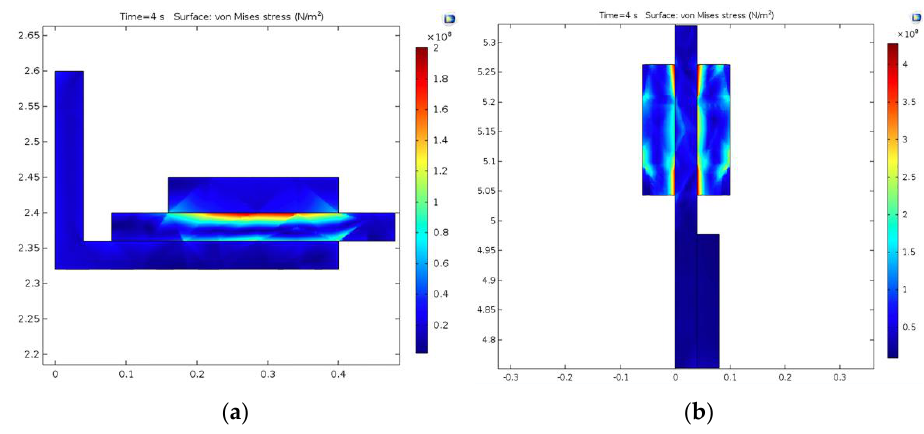
Figure 26. von Mises stress for: ( a ) drum-and-shoe couple; ( b ) disc-and-pads couple. The variation in time for the von Mises stress for the drum (corresponding to the three points investigated) is plotted in Figure 27a, and for the disc is plotted in Figure 27b. It is visible that the highest von Mises stress for the drum brake system appeared at the middle point, and for all three points investigated, the maximum values occurred before the stopping moment of the brake drum rotation. The von Mises stress in the disc brake systems was 25 – 30% lower than the drum brake.